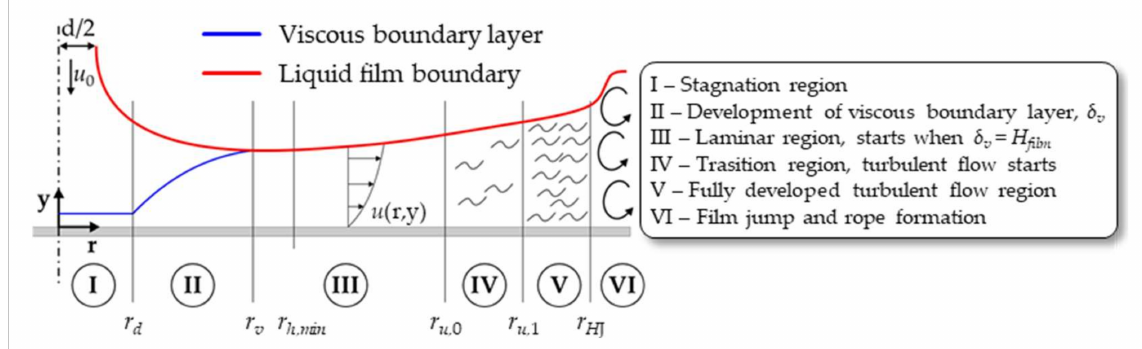
Figure 3. Sketch of the different flow regimes of the liquid film on the workpiece surface (not to scale). (Adapted with permission from [35]. Copyright 2022 ASME